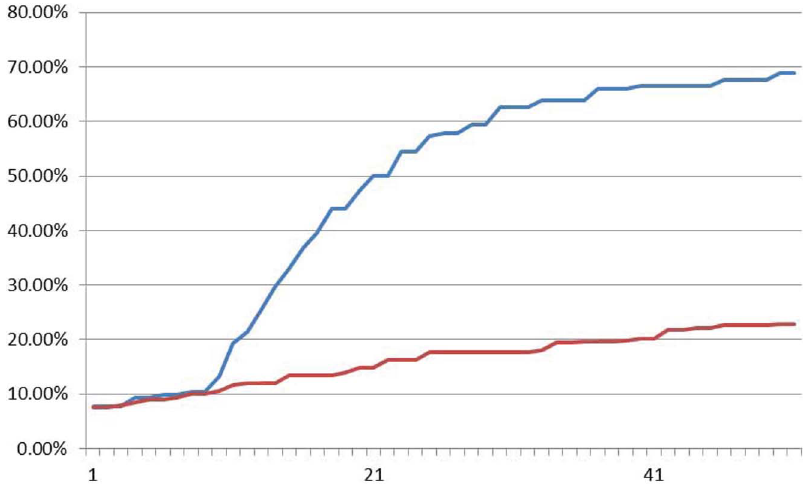
Figure 13. Fluoroscence data of DNA Neurons execute AND logic with input ‘‘00’’. The X-axis is cycling time of Real-time PCR, the time span of each cycle is 10 minutes, temperature of each cycle keeps in 24–25 u C. The Y-axis is relative intensity of HEX (red curve) and FAM (blue curve).